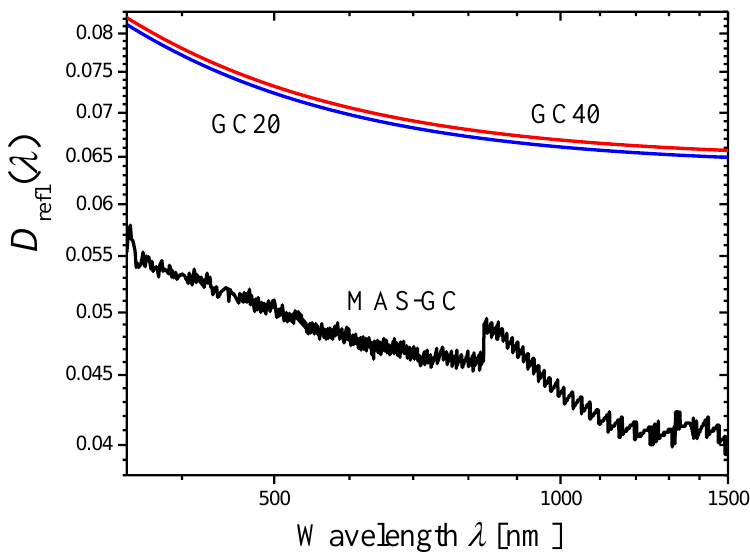
Figure 13. Optical densities of reflection losses, D refl ( λ ) , calculated for the glass-ceramics GC20, GC40 and MAS-GC (log–log plots). For the glass-ceramics GC20 and GC40, Equation (6) and analytical expressions for refractive index n ( λ ) were used. In the case of the glass-ceramic MAS-GC, calculation was carried out by Equation (34) using the measured optical densities of two samples.